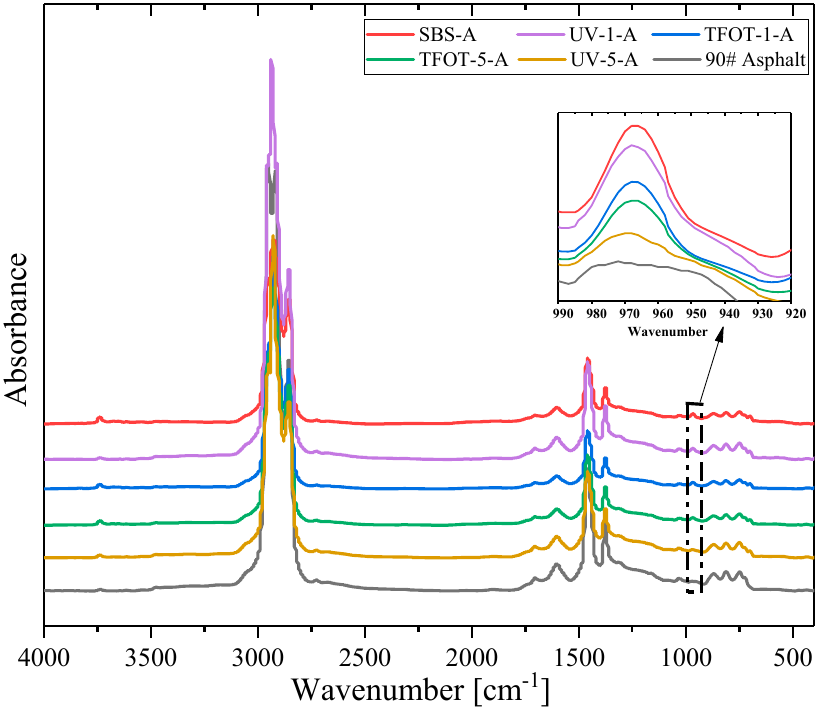
Figure 14. FTIR spectra of aged samples.